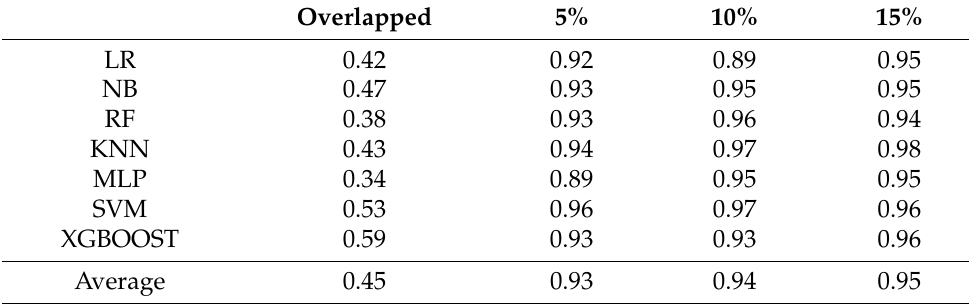
Table 5. Performance comparison of classifiers in terms of G-Mean.